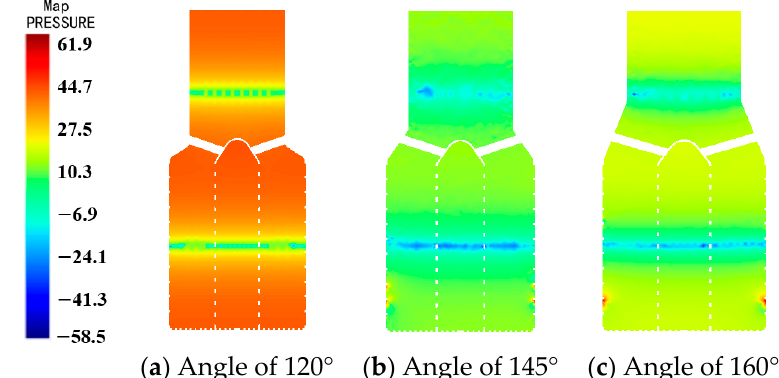
Figure 19. Sound pressure level distribution of different schemes at the third peak.